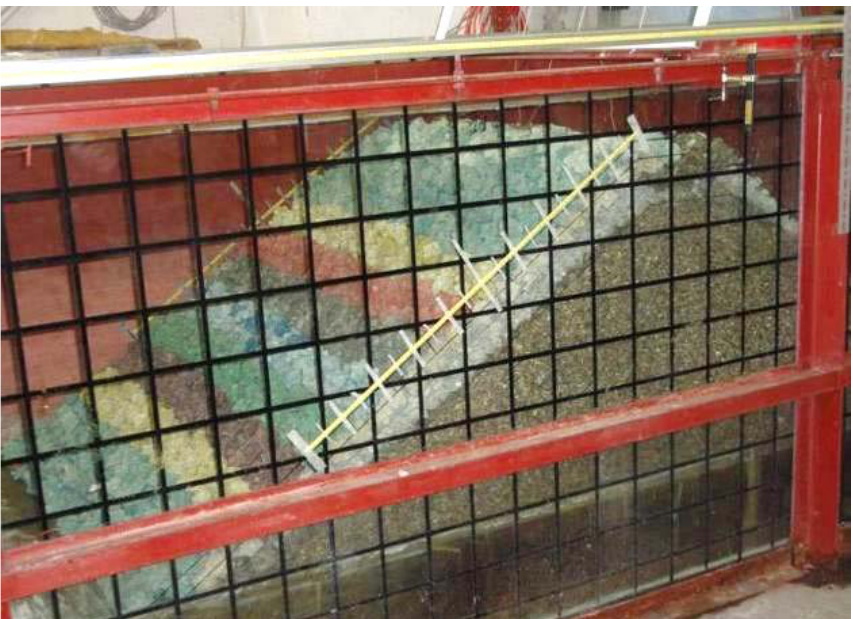
Figure 2. View of a double-layer Cubipod ® armored breakwater model without toe berm tested at the LPC-UPV.